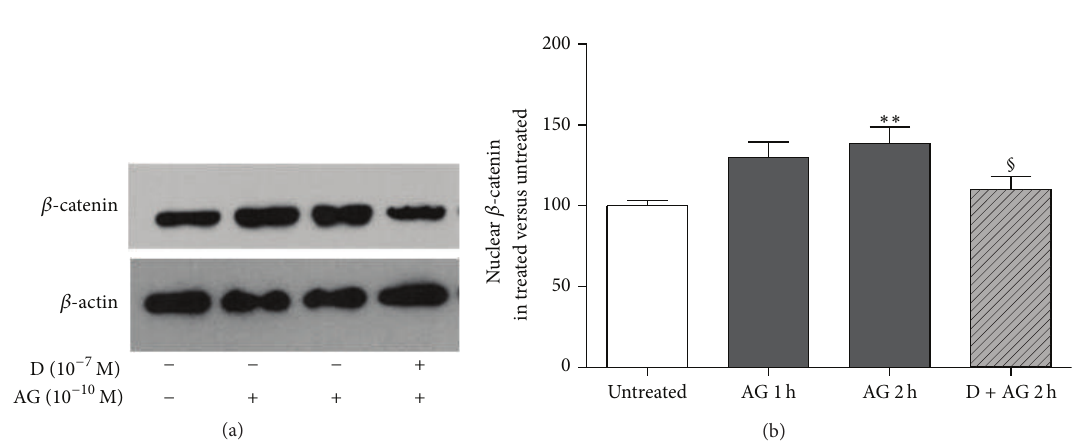
Figure 3: Representative Western blot (a) and quantification (b) of 𝛽 -catenin levels in the enriched nuclear fraction of rat osteoblast-like cells exposed to ghrelin (AG, 10 −10 M for 1 and 2h) alone or together with D-Lys 3 -GHRP-6 (D, 10 −7 M 30 min before AG), a GHSR-1a receptor antagonist. 𝛽 -catenin levels are normalized on 𝛽 -actin protein levels and results are expressed as the ratio of 𝛽 -catenin amount measured in treated cells to the amount obtained in untreated cells. Data are the mean ± SEM of five experiments ∗∗ 𝑃 < 0.01 versus untreated; § 𝑃 < 0.05 versus 2h AG treated cells.